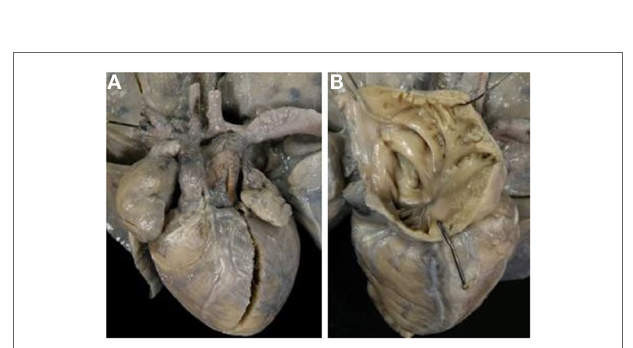
FigUre 14 | Discordant Va connection with absent right aV connection in situs solitus (tricuspid atresia) . (a) External view of the heart: the aorta is in right anterior position and severe hypoplasia of the aortic arch with aortic coarctation is present. (B) View of the right atrium with absence of the right AV